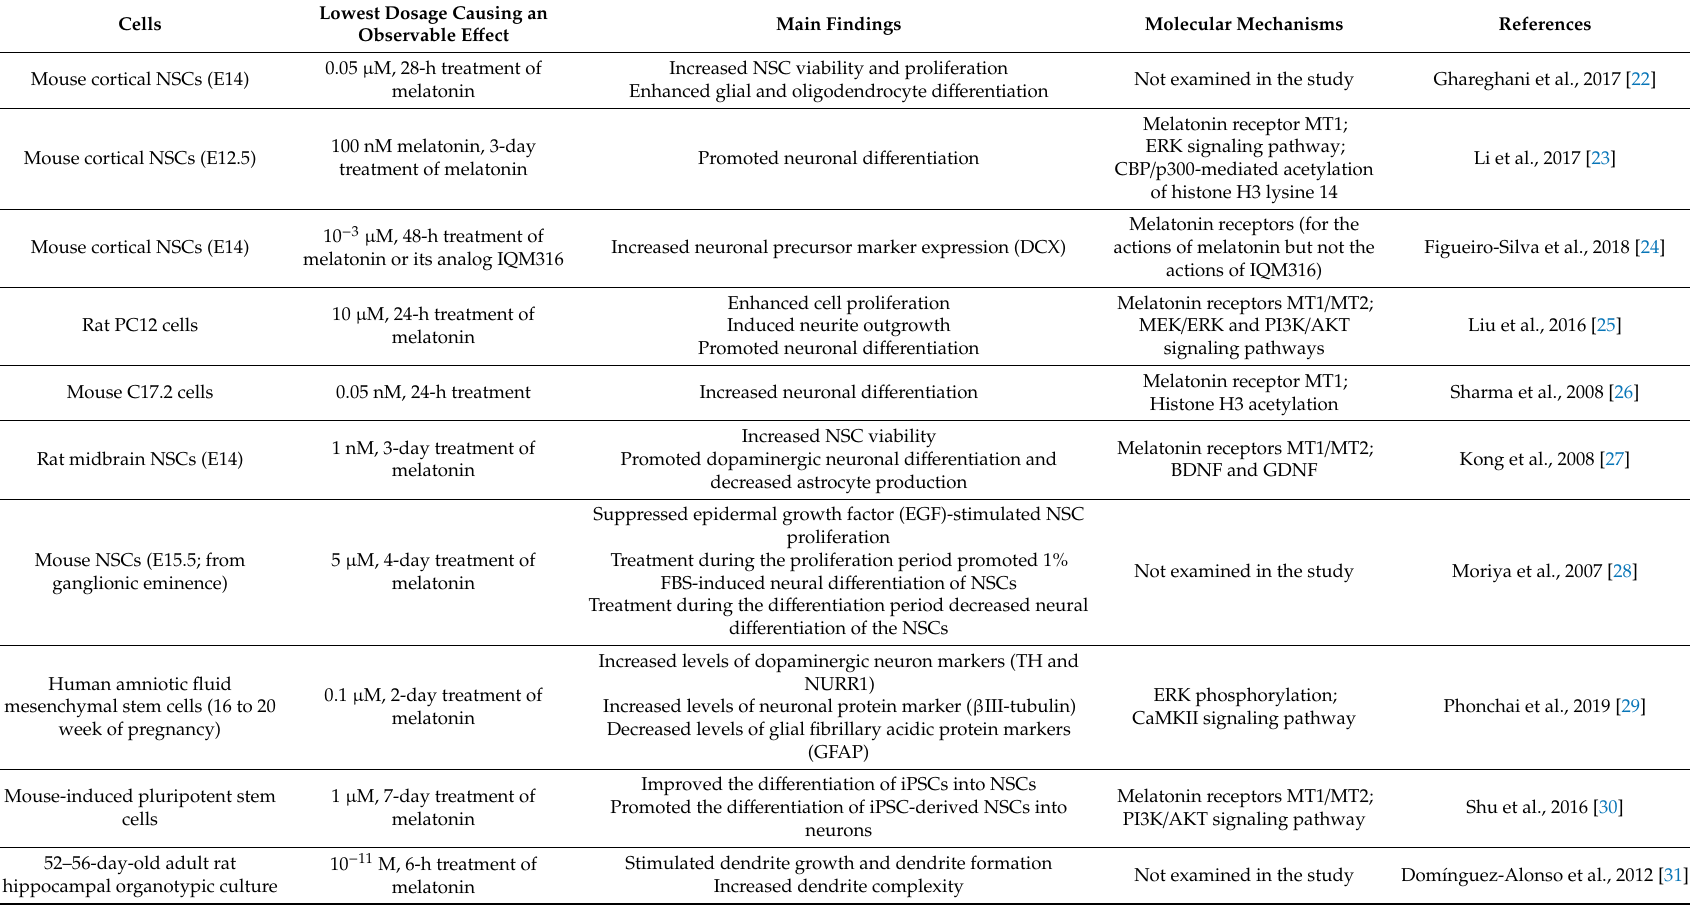
Table 1. Table showing the main findings regarding the e ff ects of melatonin or its analog(s) on neurogenesis and the respective molecular mechanisms in the in vitro